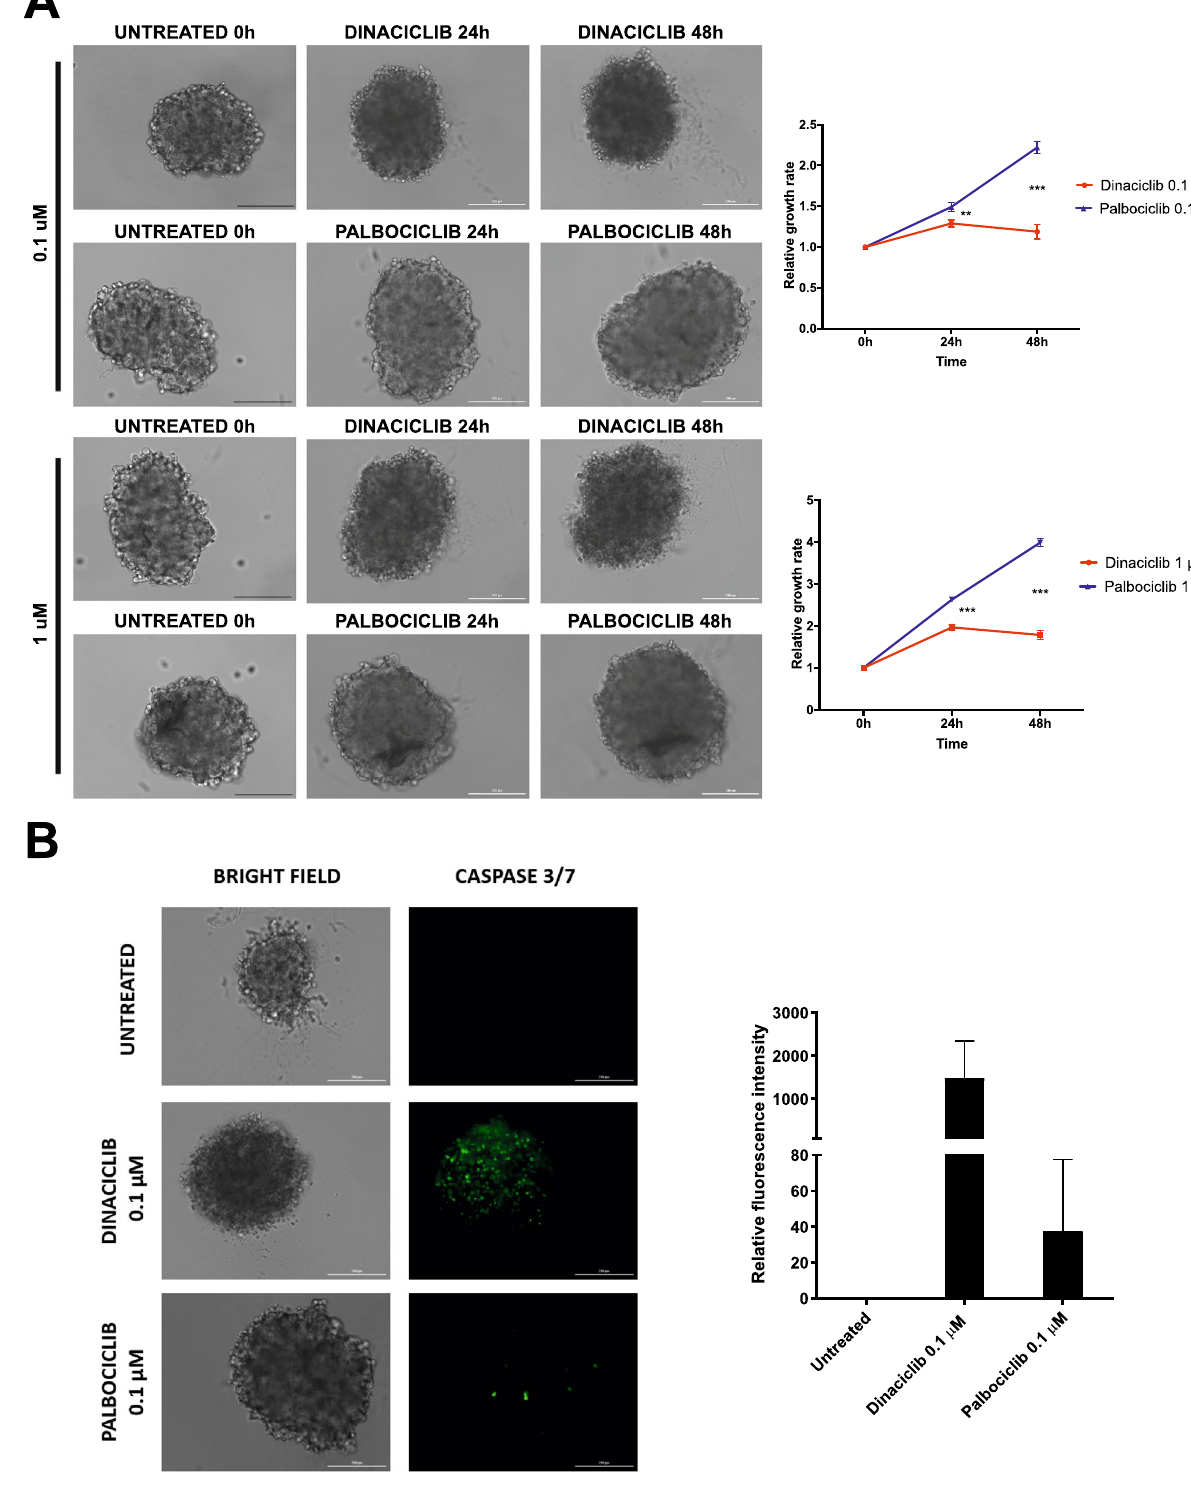
Figure 4. Dinaciclib elicits strong inhibitory effects in 3D medullospheroids and comparable to 2D settings. ( A ) Representative phase-contrast images of HD-MB03 spheroids treated with indicated concentrations of dinaciclib or palbociclib. Each spheroid was imaged before treatment at time 0, at 24 h and 48 h after treatment at 100 × magnification. Scale bar = 200 µm. On the right, relative growth rates values of presented images relative to respective time 0. ( B ) HD-MB03 spheroids were treated with dinaciclib or palbociclib for 24 h. CellEvent Caspase 3/7 Green detection reagent was added to live cells and fluorescent signal of apoptotic cells (green) was detected at 100 × total magnification. Representative images are shown. On the right, fluorescent signal quantifications are relative to the untreated control. Statistical comparisons were performed using an unpaired, two-tailed Student t-test where ** P < 0.01; *** P < 0.001. Plotted graphs show mean ± SD (n = 4 technical